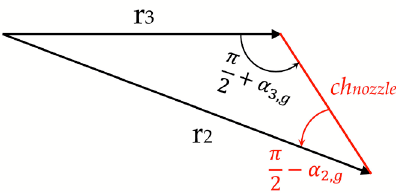
Figure 7. Geometric representation of the nozzle. Figure 7. Schematic representation of nozzle